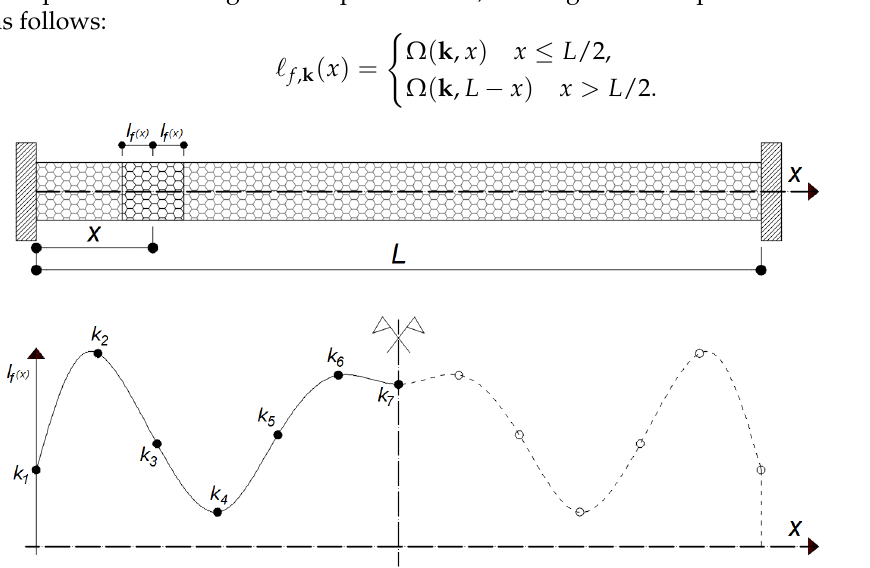
Figure 1. General scheme and length scale parameterization: ( top ) 1D space-fractional non-local formulation (sFCM) body of length L fixed at both ends; ( bottom ) spatial length scale distribution (cid:96) ( x ) through 1D sFCM f